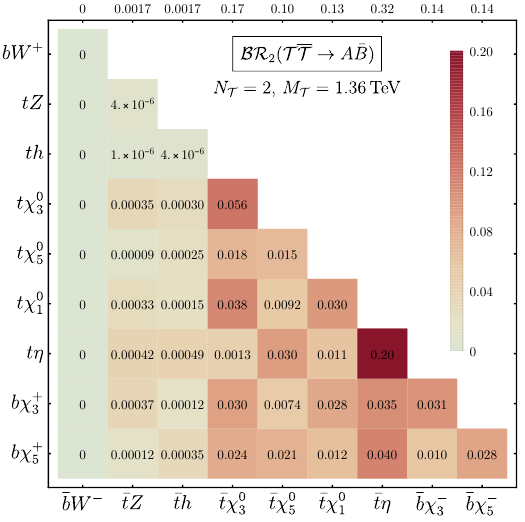
Figure 5 . Joint branching ratios BR 2 ( T T → A ¯ B ) as in eq. (4.4) for our benchmark parameter choice where A ( ¯ B ) is given in the vertical (horizontal) axis of the plot. Since BR 2 ( T T → A ¯ B ) is a symmetric matrix we only present the lower triangle. The numbers on the top of the figure show the values of BR ( T → A ) as given in eq.